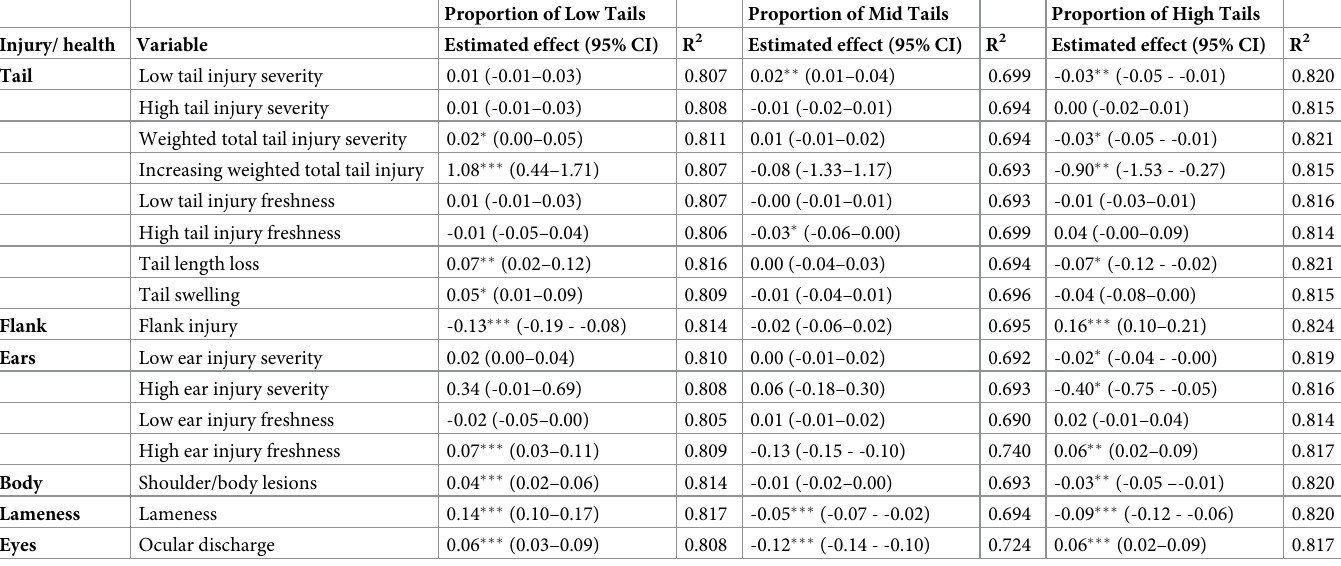
Table 4. Results of linear mixed models of tail posture by injury and health scoring metrics.